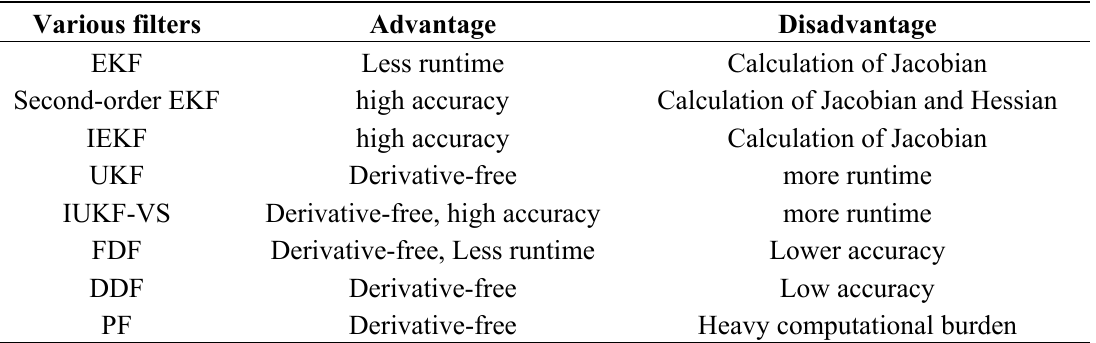
Table 1. Pro and cons for various